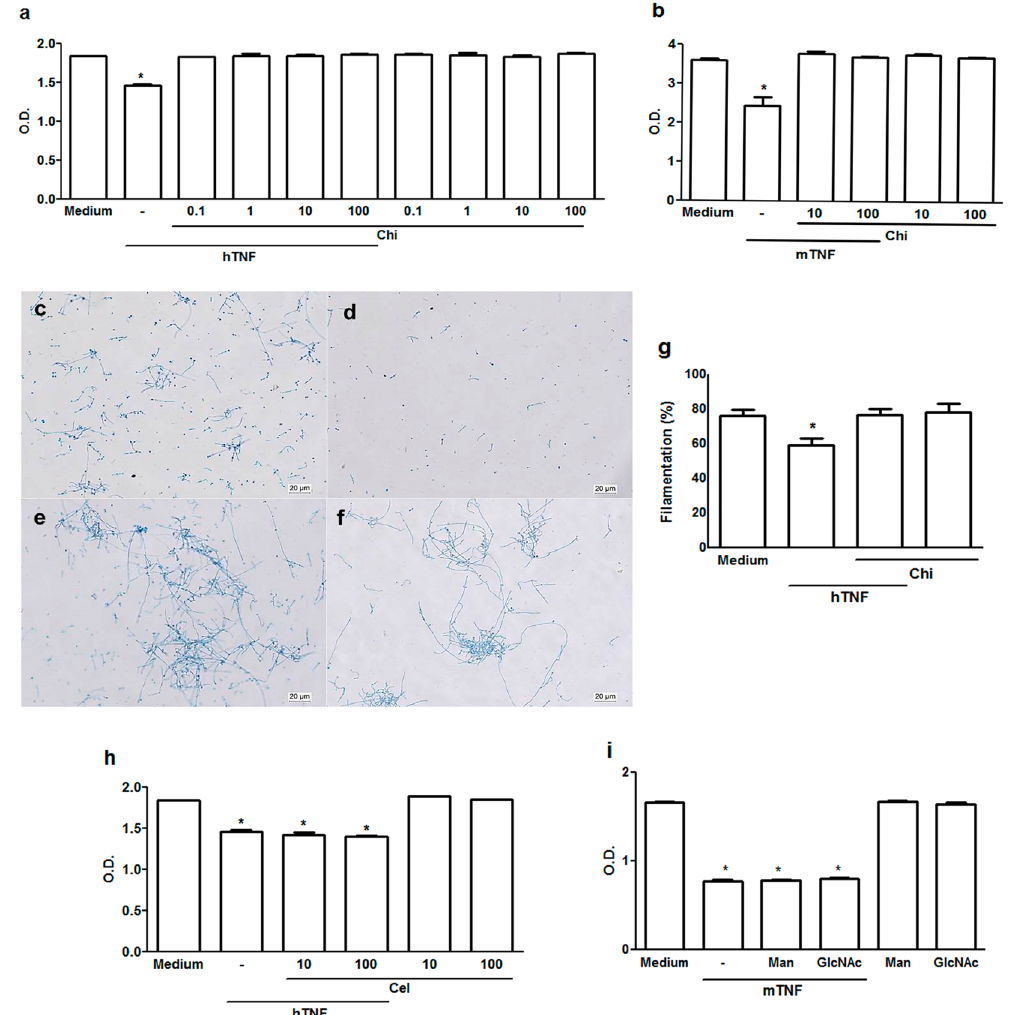
Figure 5. N,N -diacetylchitobiose blocks TNF effect on C. albicans biofilm. ( a , b ) N,N -diacetylchitobiose (Chi µ g/mL) isolated or combined with hTNF or mTNF (ng/mL) or medium ( − ) was added to C. albicans ATCC 10.2.31 biofilm (metabolic activity − XTT assay); optical microscopy of biofilms grown with medium ( c ), medium + mTNF 20 ( d ), medium + mTNF (20) + Chi (100) ( e ), or medium + Chi (100) ( f ) for 48 h (Original x200); ( g ) filamentation index of biofilms after 48 h growth with medium, medium + hTNF (20), medium + hTNF + Chi (100) or medium + Chi (100); ( i ) metabolic activity after treatment with cellobiose (Cel), mannose (Man) or N-Acetylglucosamine (GlcNAc). Data represent the mean ± SEM Absorbance 492nm of two independent experiments conducted in triplicate; * P < 0.001 . Filamentation index represents the percentage of hyphae/blastoconidia in 10 hpf (Original